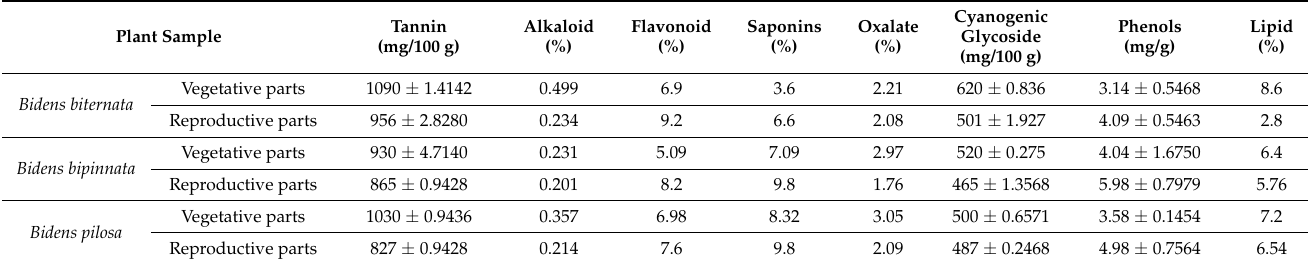
Table 3. Quantity of Phytochemicals found in Bidens species.